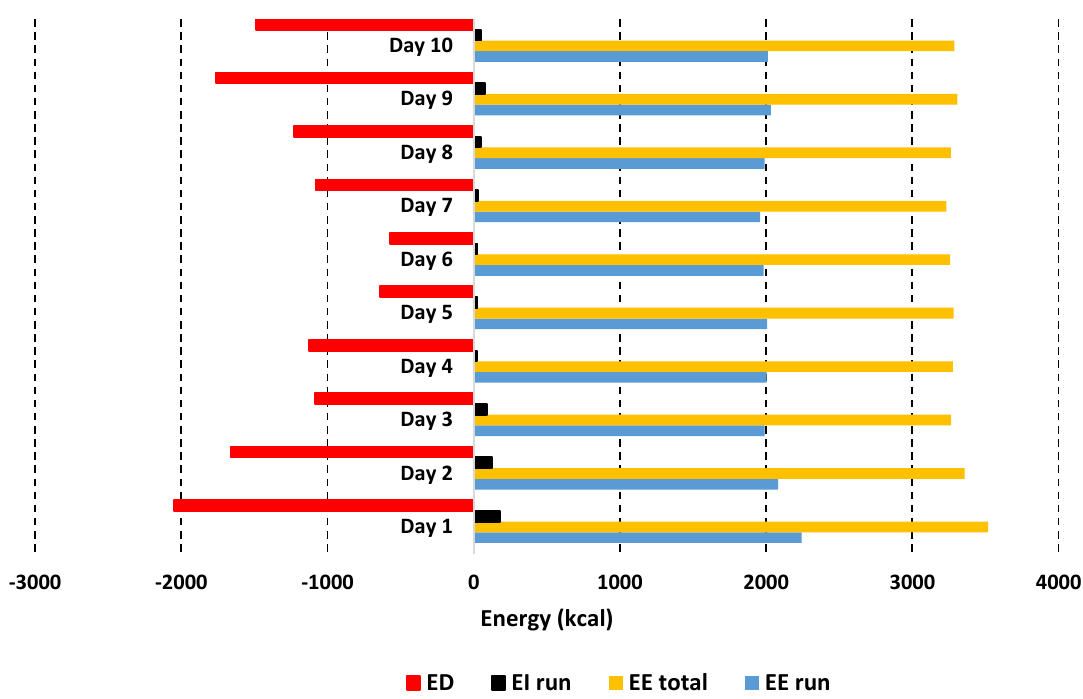
Figure 1. Energy intake (EI), energy expenditure (EE) and energy deficit (ED). Please note that the overall EI matches the EE during the runs, but overall, there is a significant ED every day due to EE from BMR and other activities. 0.01.02.03.04.05.06.07.08.0